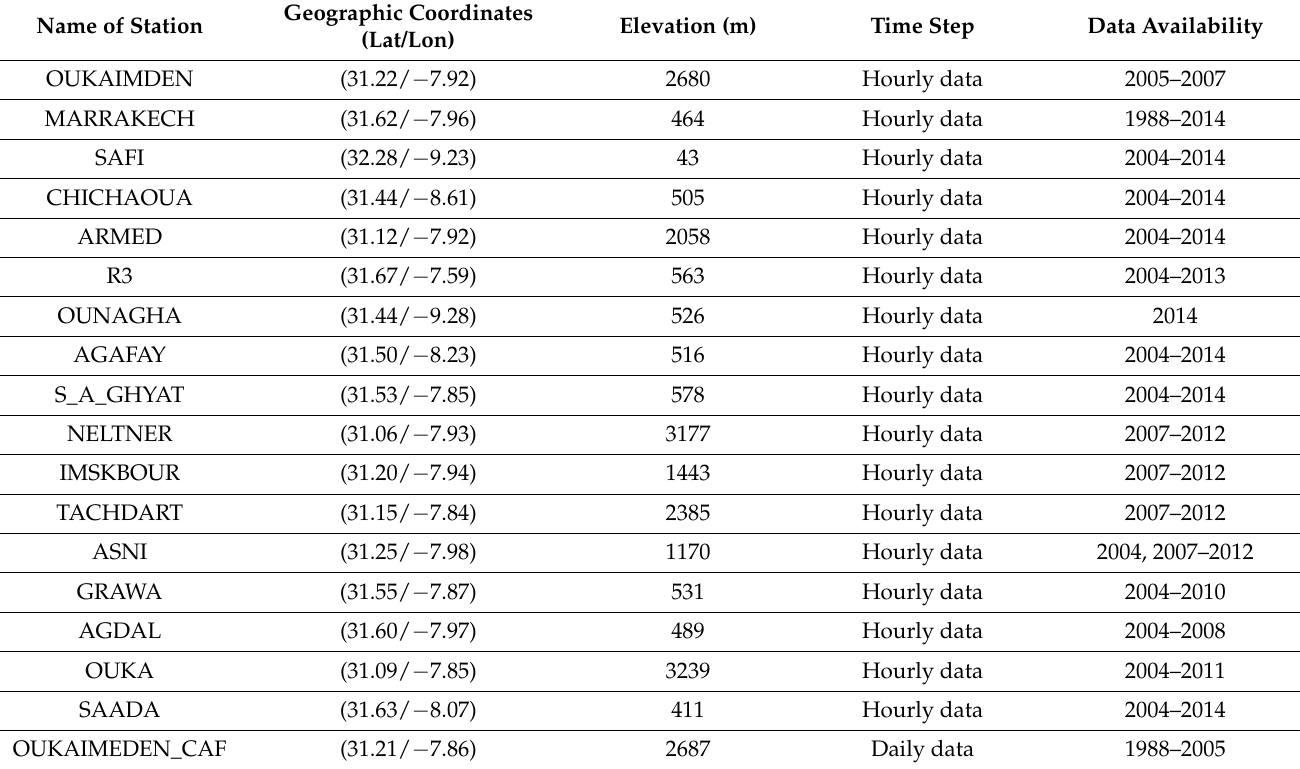
Figure 1. The Tensift catchment and the orography (digital elevation model STRM at 30m). The location of the meteorological stations and the division of the catchment area into 23 climatically homogeneous zones for the SAFRAN system (see text) are superimposed. Table 1. The meteorological observation stations, geographical positions, the time step of the data and availability